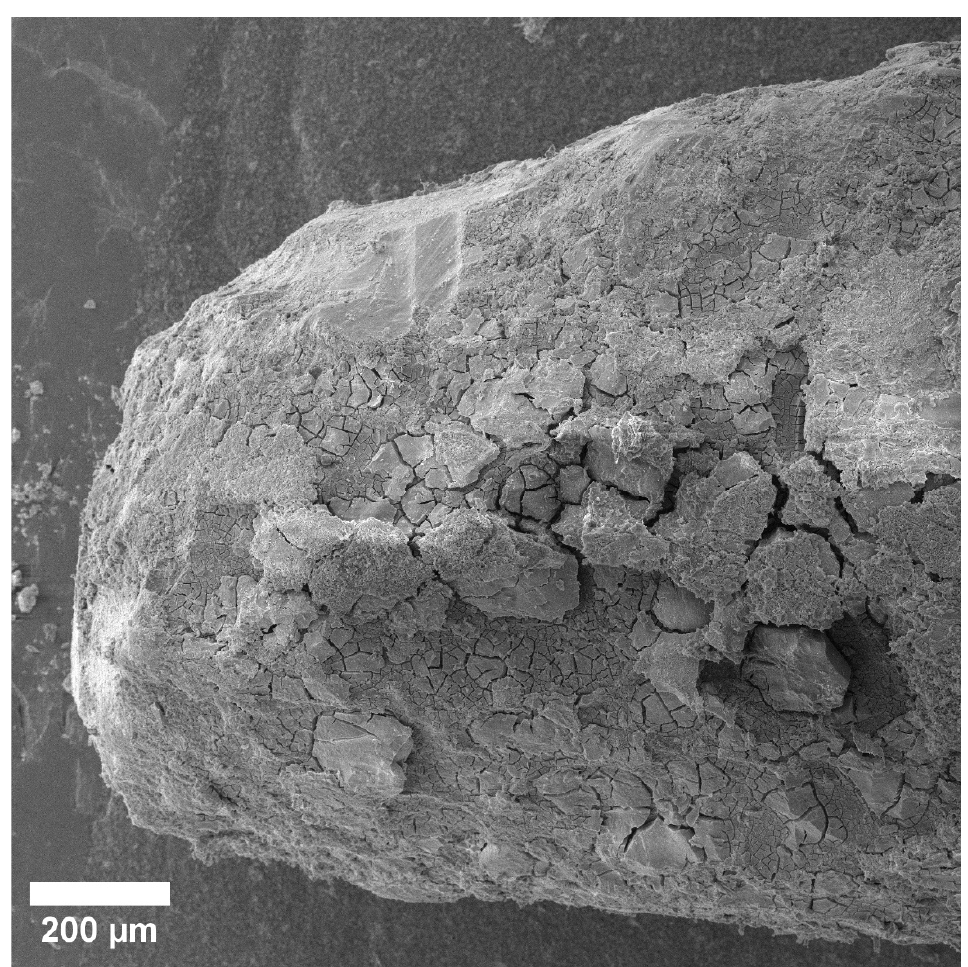
Figure 1. SEM image of magnesium implant surface obtained by reflection of secondary electrons 1 month after installation.